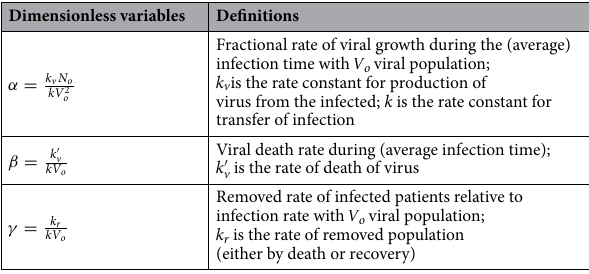
Table 1. Emerging indicators from pathogen